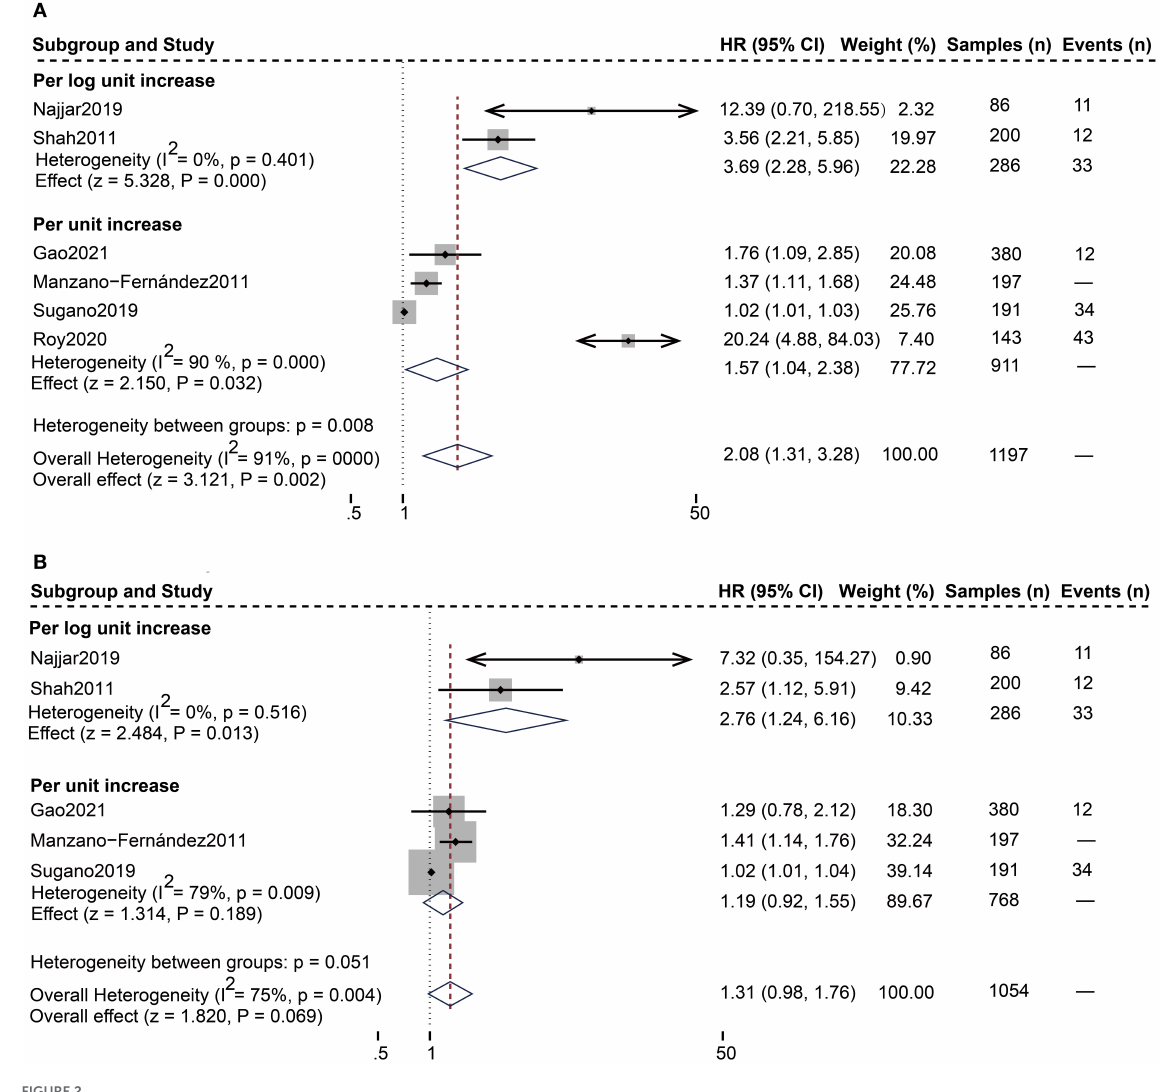
FIGURE2 Forest plot of the association between serum sST2 and all-cause death. (A) Univariate analysis in the prediction of all-cause death. (B) Multivariate analysis in the prediction of all-cause